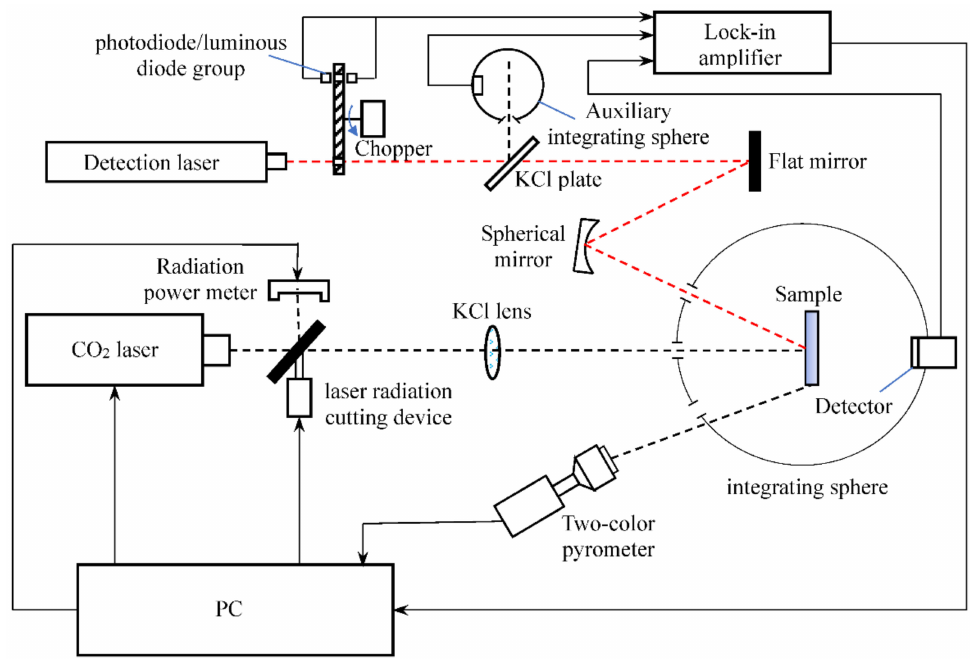
Figure 9. Measurement system of normal-hemispherical reflectance under high temperatures [62].